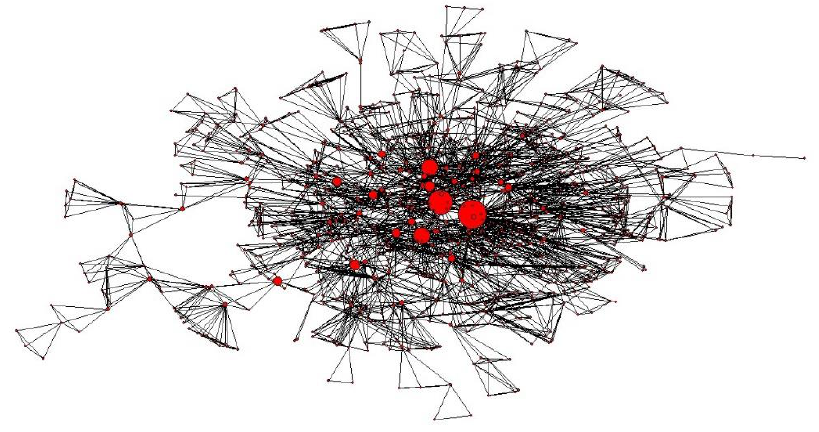
Figure 5. network related to Betweenness (year: